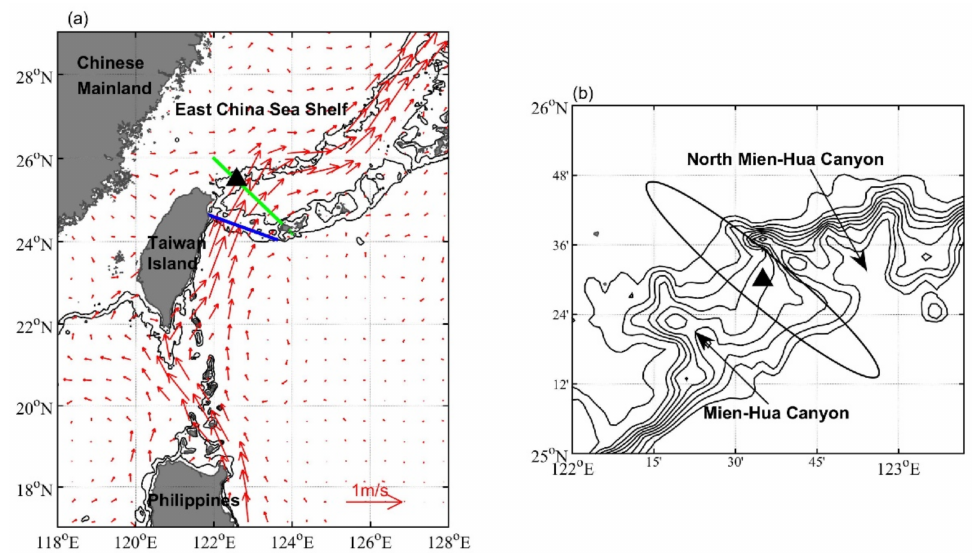
Figure 1. ( a ) Mean geostrophic velocities (red arrows, from satellite altimetry data). The blue line represents the East Taiwan Channel (ETC) transect, and the green line represents the P transect. Thin contours are the 200 m and 1000 m isobaths (ETOPO1 Global Relief Model). The mooring location is labeled as the black triangle. ( b ) Detailed topography around the mooring station. Thin contours are the isobaths every 100 m from 200 m to 1000 m. The M 2 tidal ellipse is